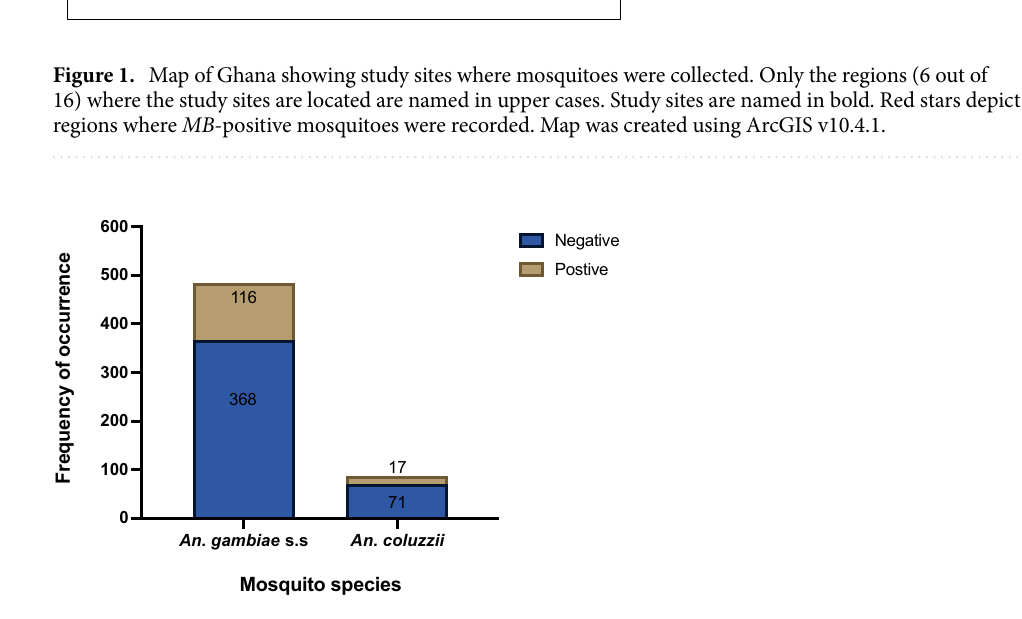
Figure 2. Microsporidia positivity rate in An. gambiae s.s and An. coluzzii . Numbers within the bar plot show the total number of mosquitoes observed for each